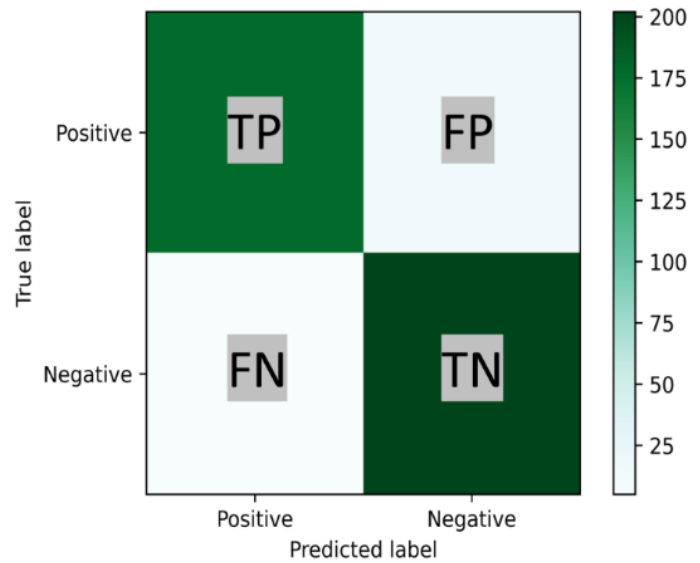
Figure 1. Confusion Matrix Binary Classification; TP represents the number of positive and TN the negative instances that are correctly classified. For its part, FP and FN represent the number of misclassified negative and positive instances, respectively.